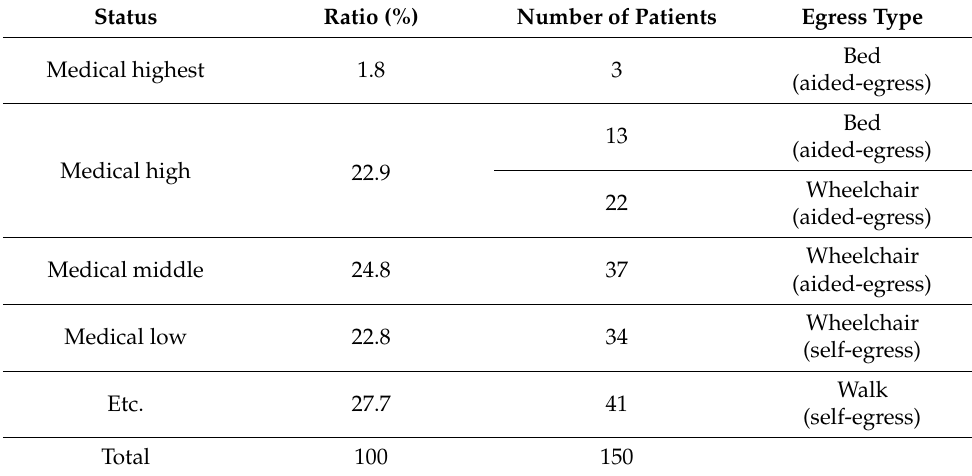
Figure 3. Simulation model for egress. Table 1. Number of patients according to severity and egress type.